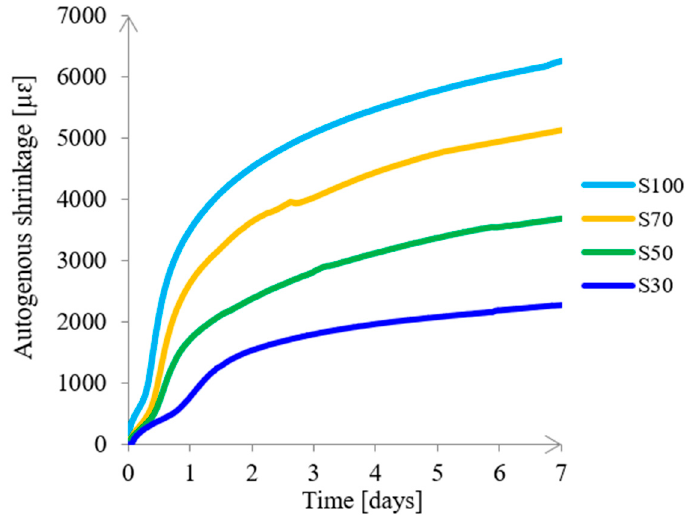
Figure 17. Autogenous shrinkage of alkali activated pastes (l/b = 0.5).